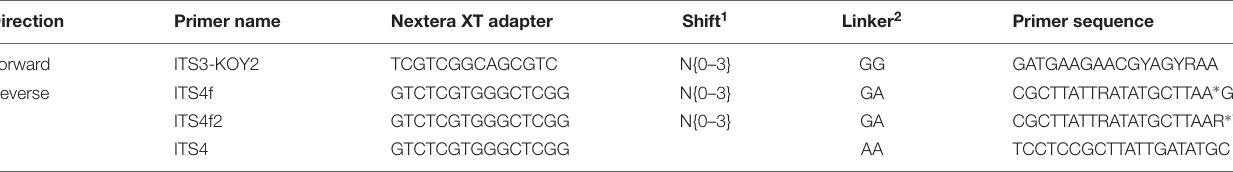
TABLE 1 | Fusion primers used in the primer test and for amplification of the leaf samples.